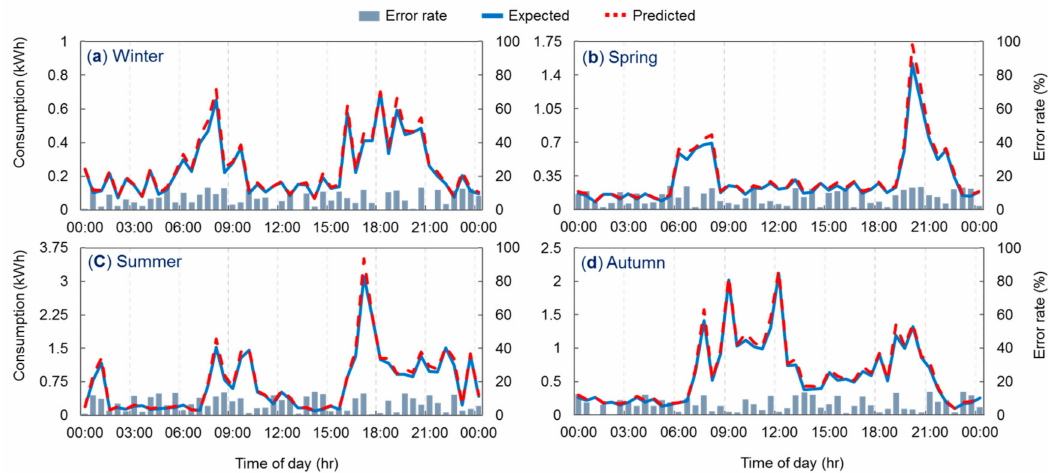
Figure 9. Comparison between the actual and predicted electricity consumption for the training results of ANN5 for a typical day in four seasons: ( a ) winter; ( b ) spring; ( c ) summer; and ( d ) autumn.